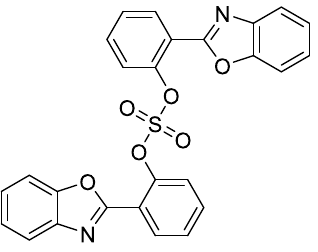
Figure 3. Structure of by-product bis (2-(benzoxazol-2-yl)phenyl)sulfate.